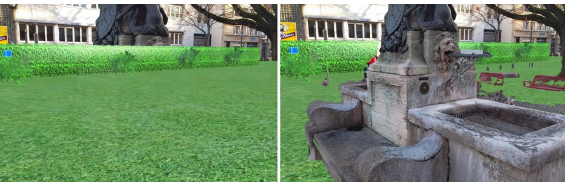
Figure 6. Occlusion screening based on the Spatial Map. ( left ) Disabled. ( right ) Enabled.